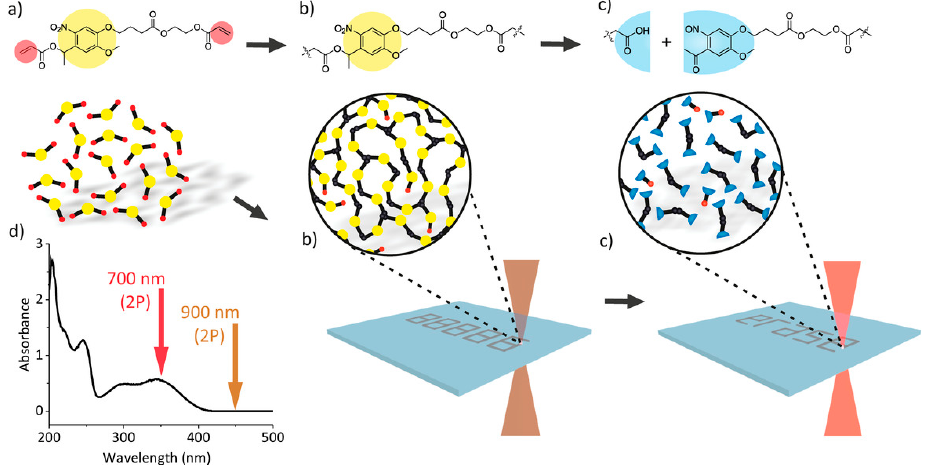
Figure 54. Representational diagram of printing and cleaving process: ( a ) structure of acrylate with pendant o -nitrobenzyl ester (ONB) monomer; ( b ) micro-fabrication using DLW (900 nm wavelength) via radical photo-polymerization of acrylates; ( c ) selective cleavage of the resist at 700 nm wavelength through o -NB cleavage; ( d ) UV-vis spectrum of the ONB monomers. Arrows indicate the corresponding two-photon wavelengths for printing and cleaving. Reproduced with permission from [383]. Copyright © 2022 John Wiley and Sons.